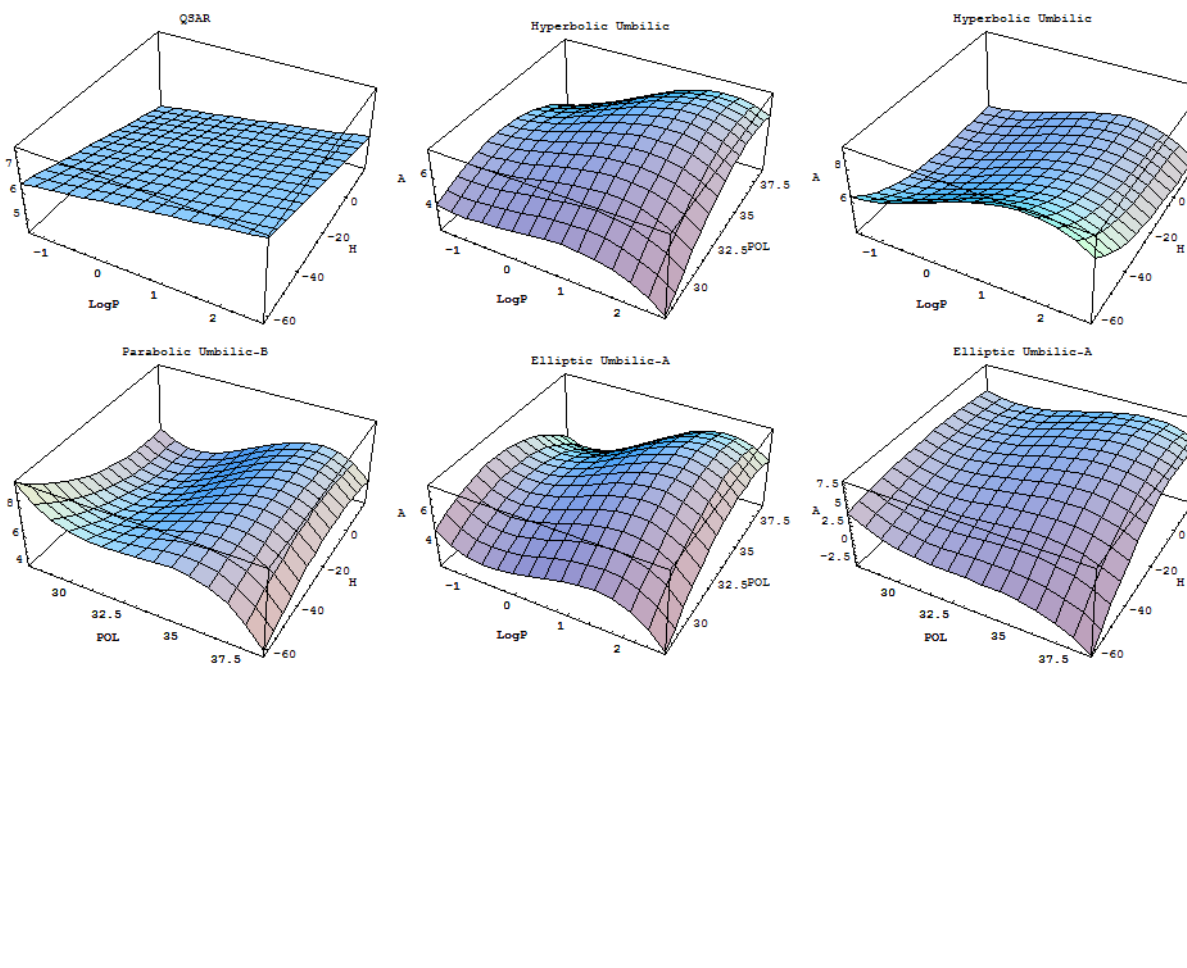
Figure 2. 3D-representations of the QSAR and catastrophe activities for the tested models of Table 11 in the range of the structural indicators (Log P, Pol, H) as abstracted from Table